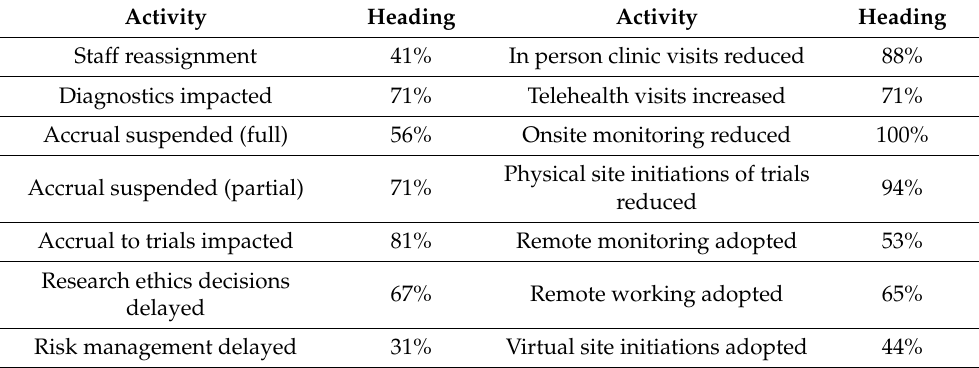
Table 1. Impact of the pandemic on the 17 clinical trials units surveyed a .